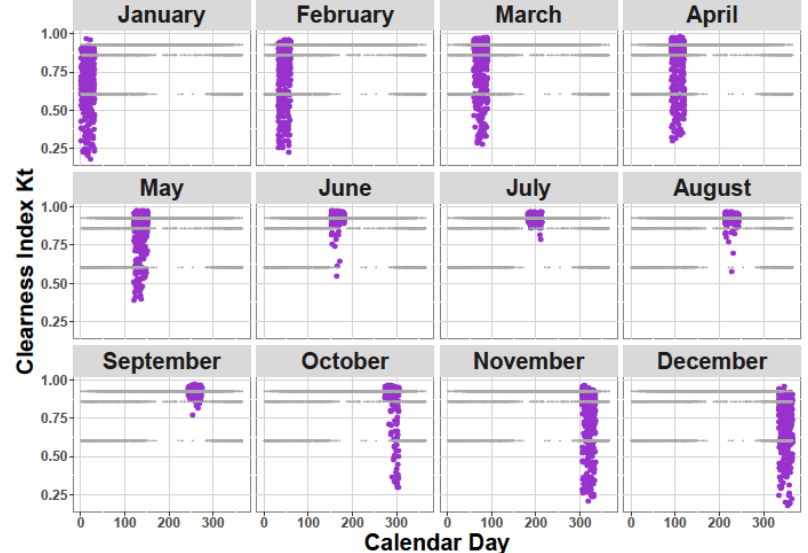
Figure 9. Posterior probability of distribution components ( dark grey ) with respect to calendar day and observations ( purple